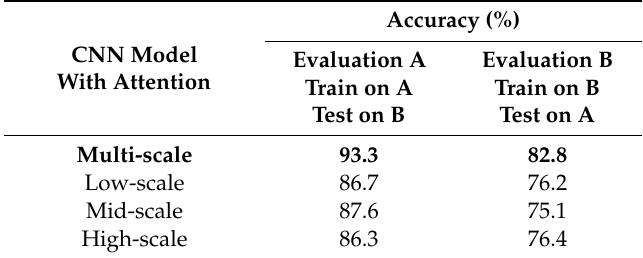
Table 3. Prediction accuracy when applying an attention